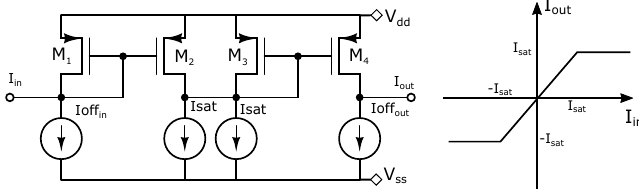
Figure 5. CMOS design of the PWL function by cascading simple current mirrors.